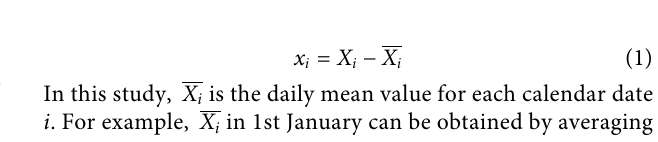
Frontiers in Environmental Science |